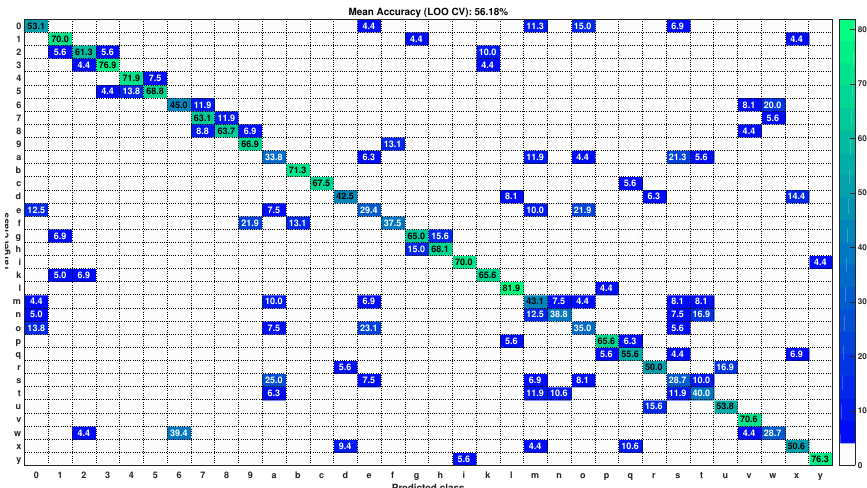
Figure 6. Confusion matrix of HUST dataset with test gesture samples in LOO CV test.